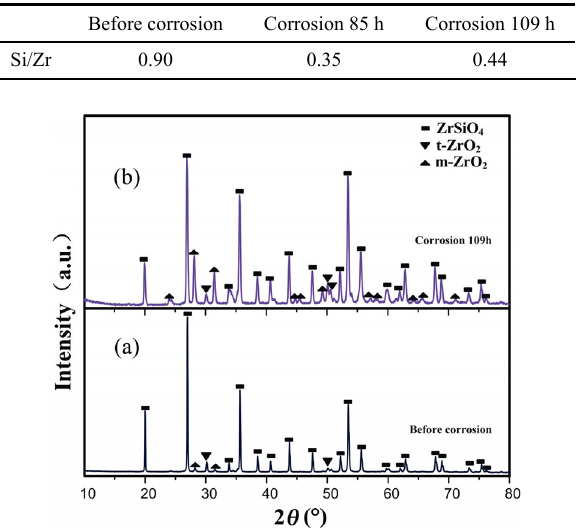
Fig. 8 Phase change of ZrSiO 4 coating (a) before and (b) after corrosion.